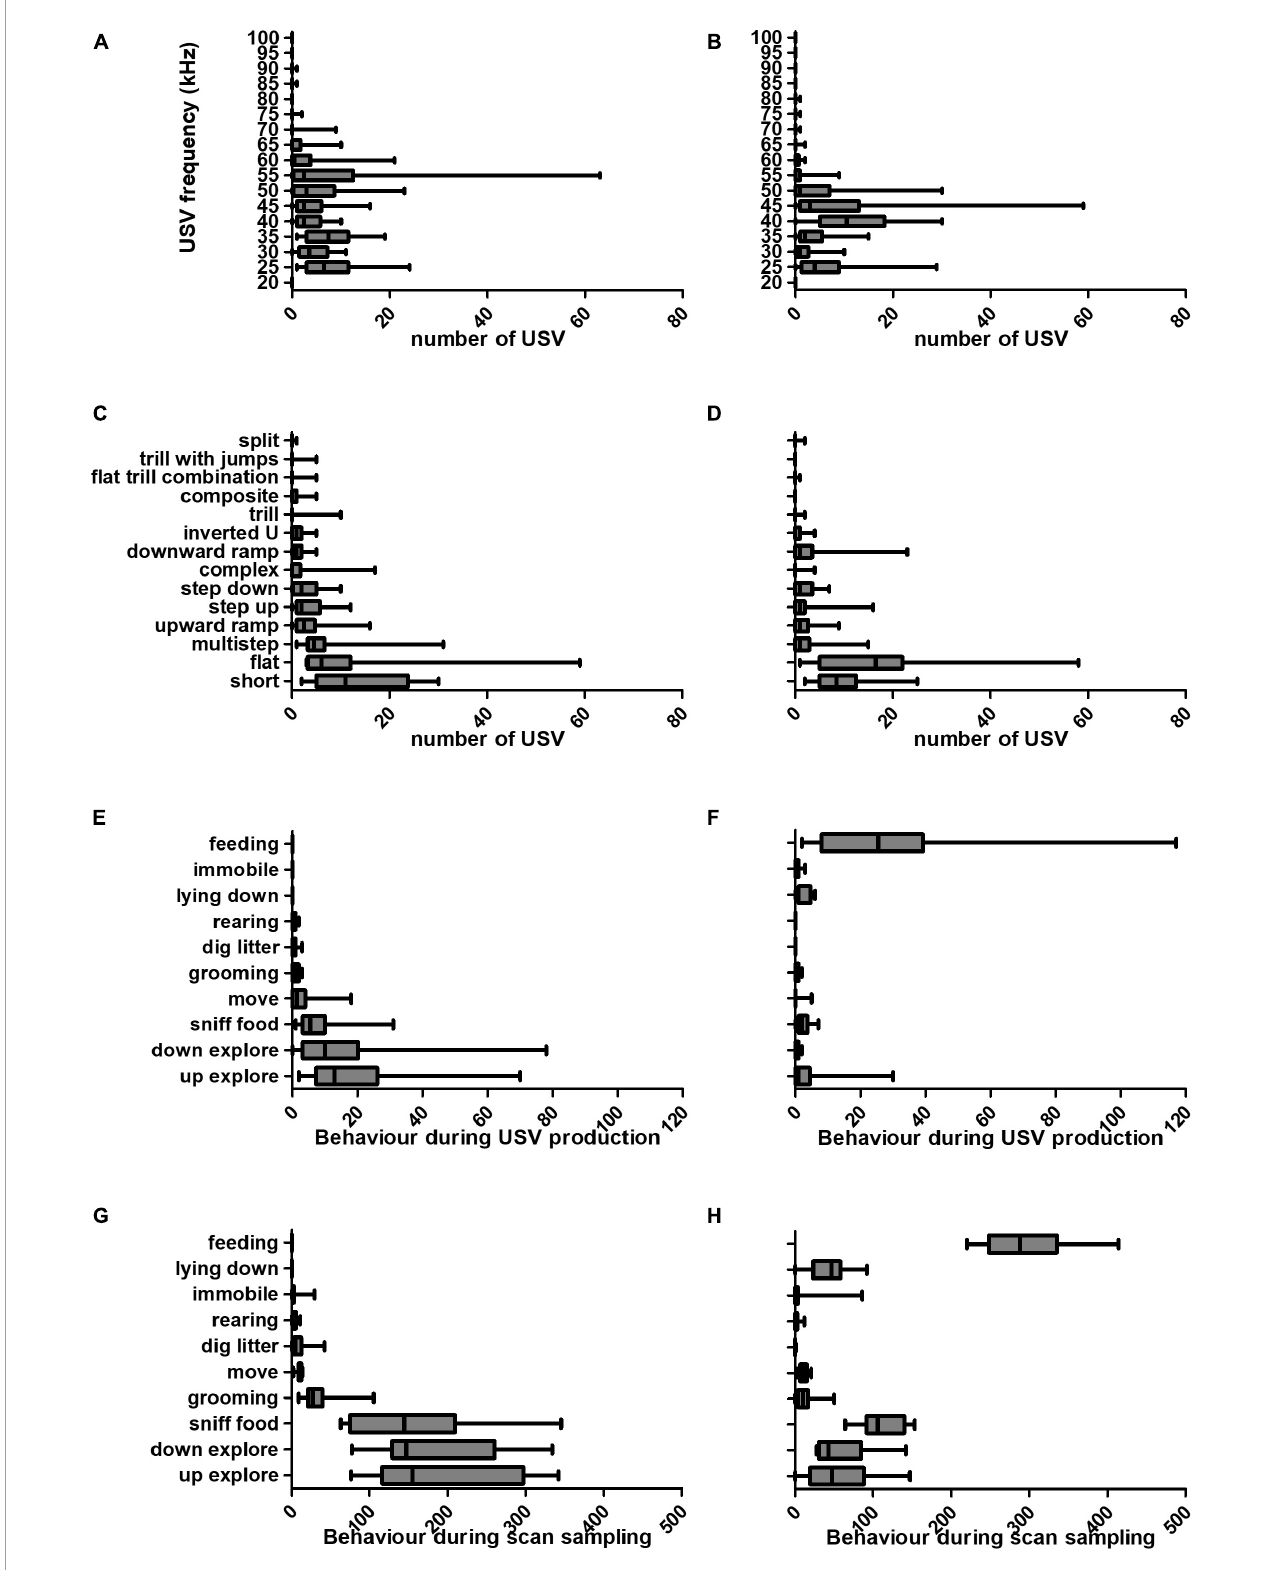
FIGURE3 Characteristics of USVs emitted (frequency and subtype), and behaviours recorded during the anticipatory and consumption meal phases. We observed a shift in USV properties (frequency and subtype) between the anticipatory and consumption meal phases. Estimated sound frequency (in kHz) of USVs produced during the anticipatory (A) and consumption (B) meal phases. USV subtypes produced by each rat during the anticipatory (C) and consumption (D) meal phases. Number of each behaviour performed upon USV production in anticipatory (E) and consumption (F) meal phases. Number of each behaviour performed in anticipatory (G) and consumption (H) meal phases. All measures were made over the duration of the anticipation and consumption phases (10 min each, or 600 s). Graphs are box-and-whiskers plots describing the minimum value, 25th percentile, median, 75th percentile, and maximum value ( N = 16